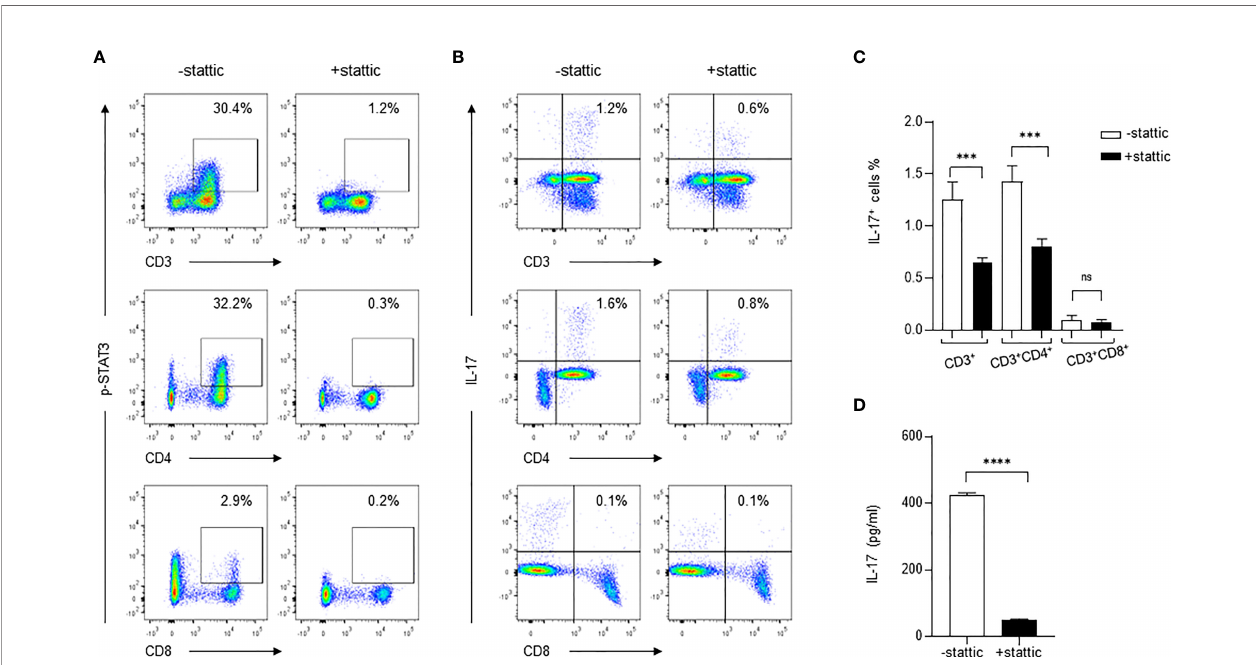
FIGURE 5 | Inhibition of STAT3 phosphorylation diminishes IL-17 production in response to C. neoformans . Peripheral blood mononuclear cells were pretreated for 30 min with STAT3 phosphorylation inhibitor stattic (2.5 m M) and were subjected to stimulation for 3 days with C. neoformans . Changes of the phosphorylated STAT3 (A) and IL-17-producing cells (B, C) were analyzed by fl ow cytometry assay, and the supernatant IL-17 level (mean ± SE) was evaluated by ELISA (D) . Representative data of three individual experiments are shown. ***0.0001<p<0.01, **** p < 0.0001; ns, no signi fi